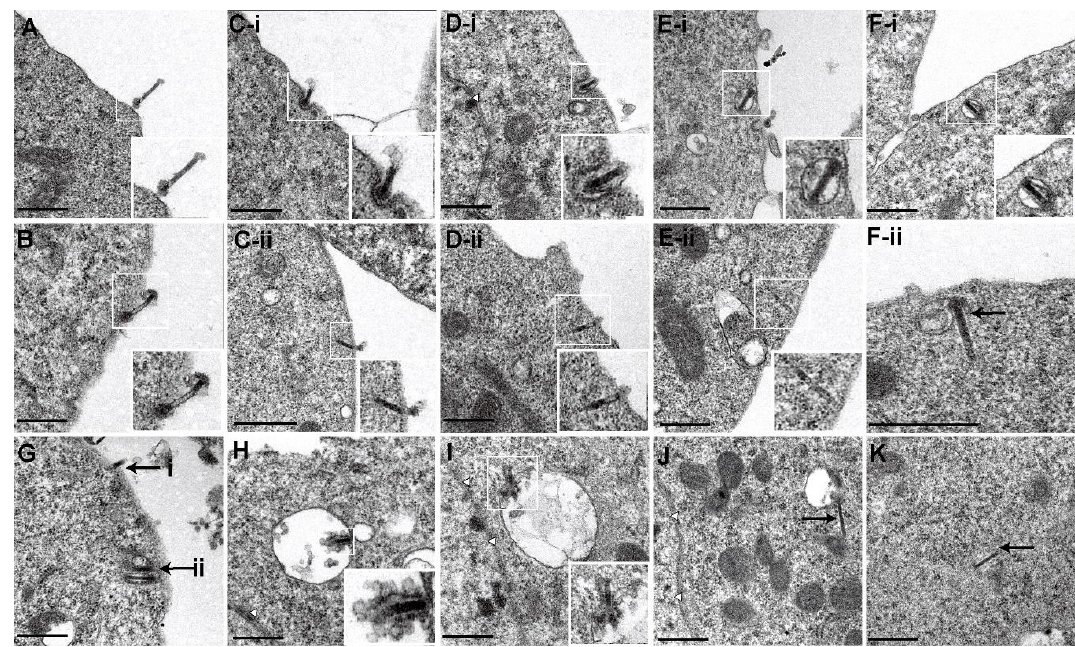
Figure 5. Ultrastructural analysis of the multiple pathway entry of AcMNPV into Sf9 cells using electron microscopy. AcMNPV particles were bound to Sf9 cells at 4 °C for 30 min, and then the temperature was raised to 27 °C for 1 h. ( A ) An enveloped virus particle that attached to the cell surface. The boxed regions of the virus particle are magnified and shown in the inset. ( B ) An enveloped virus particle that interacted with the cell surface, indicating that spikes of virus particles had bound to the receptors on the cell surfaces. The virus particles then entered cells mainly through two different pathways. Clathrin-mediated endocytosis was the primary pathway: ( C-i ) a virus particle that was partially invaginated into the cytoplasm; ( D-i ) a virus particle that was predominantly